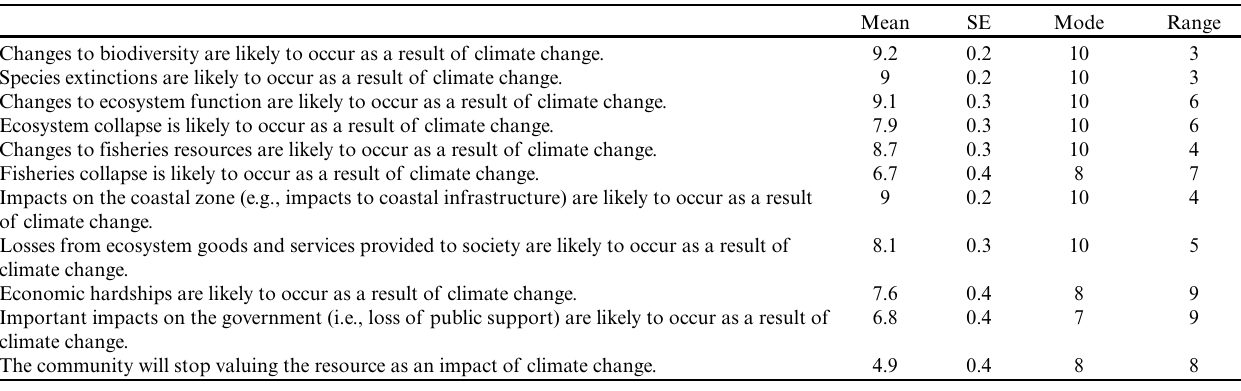
Table 1 . Perceptions of Australian marine protected areas (MPA) decision makers (n = 30) about the potential risks of climate change. Scores are based on a Likert scale between 1 and 10, where a score of 1 indicated that the participant strongly disagreed with the statement, whereas a score of 10 meant that the participant strongly agreed with the statement. Mean SE Mode Range Changes to biodiversity are likely to occur as a result of climate